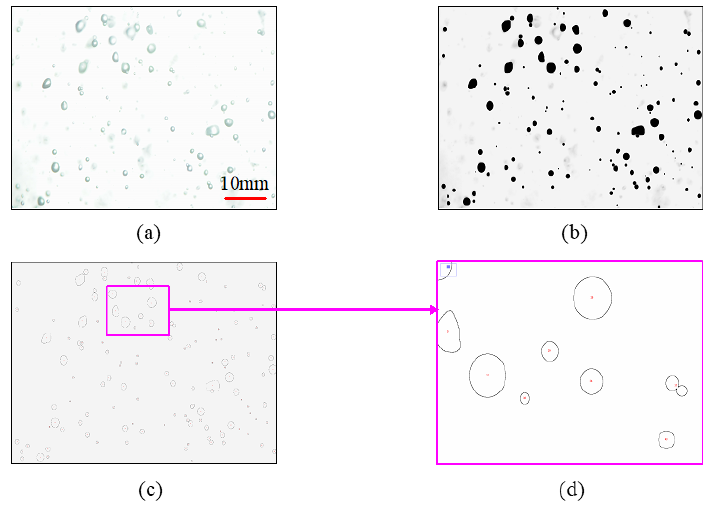
Figure 4. Two-dimensional image-processing procedure. ( a ) Image of microbubbles, ( b ) Two- dimensional image processing, ( c ) Count amount of microbubbles, ( d ) Count the enlarged image.